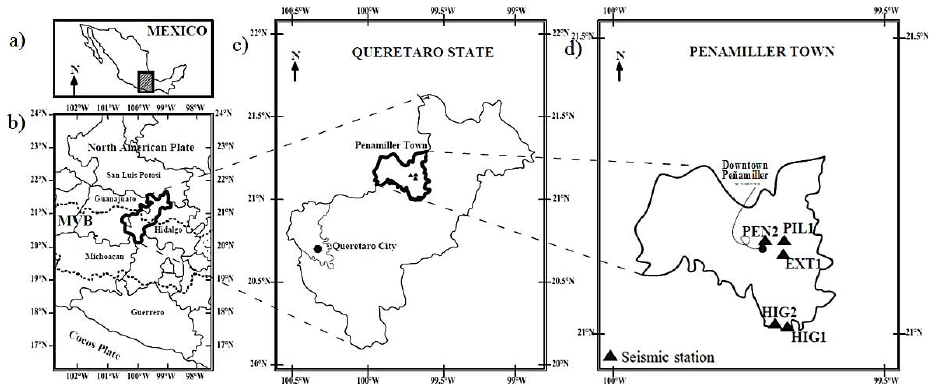
Fig. 2. The study area: northeast edge of the MVB. Location and identification of (a) Mexico, (b) Querétaro state within Mexico and delimitation of MVB zone with dotted line, (c) Peñamiller Town and Querétaro City within Querétaro state, and (d) seismic stations and Downtown Peñamiller. Table 3. Results of the locations of all events analyzed: Peñamiller Earthquake Sequence (PES). Origin time Location Error rms Event UTC Date UTC Hour Lat.